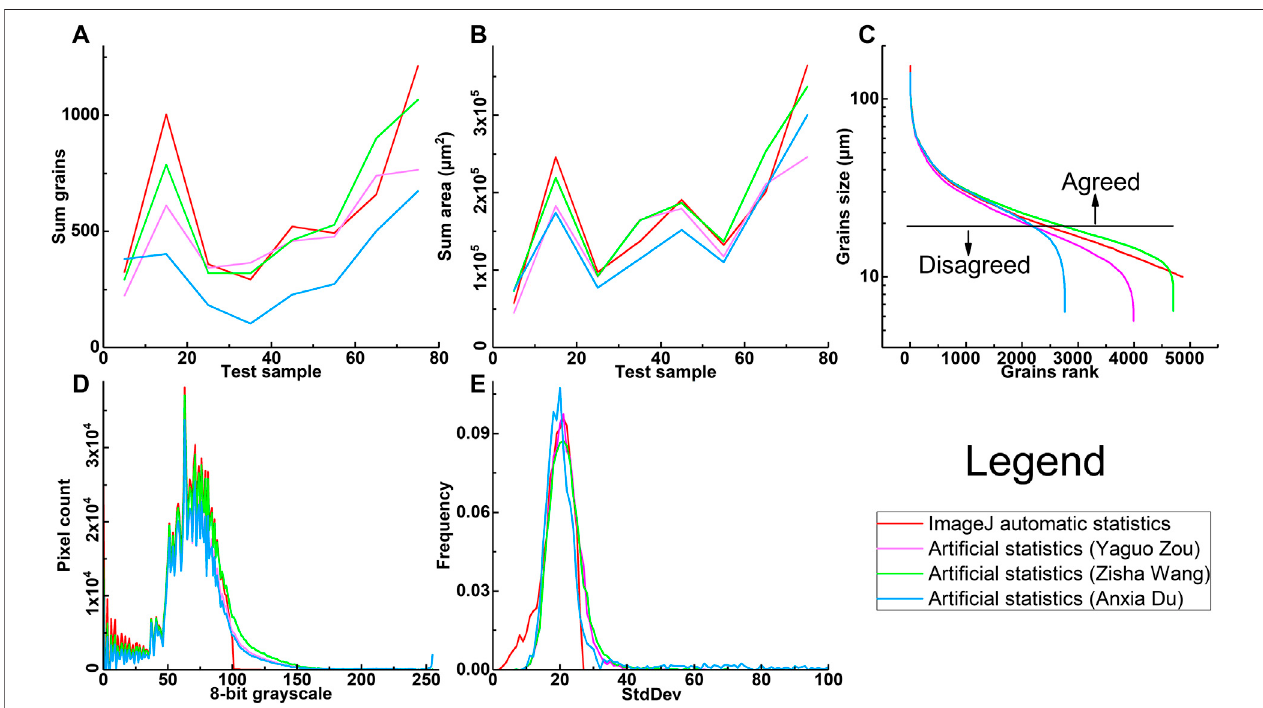
FIGURE 4 | Comparison of automatic (ImageJ) and manual statistical analysis. (A) : the total number of counted particles. (B) : the total area of counted particles. (C) : the rank-size distribution of counted particles; (D) : the distributions of grayscale values of counted pixels; (E) : the standard deviation of grayscale values of counted